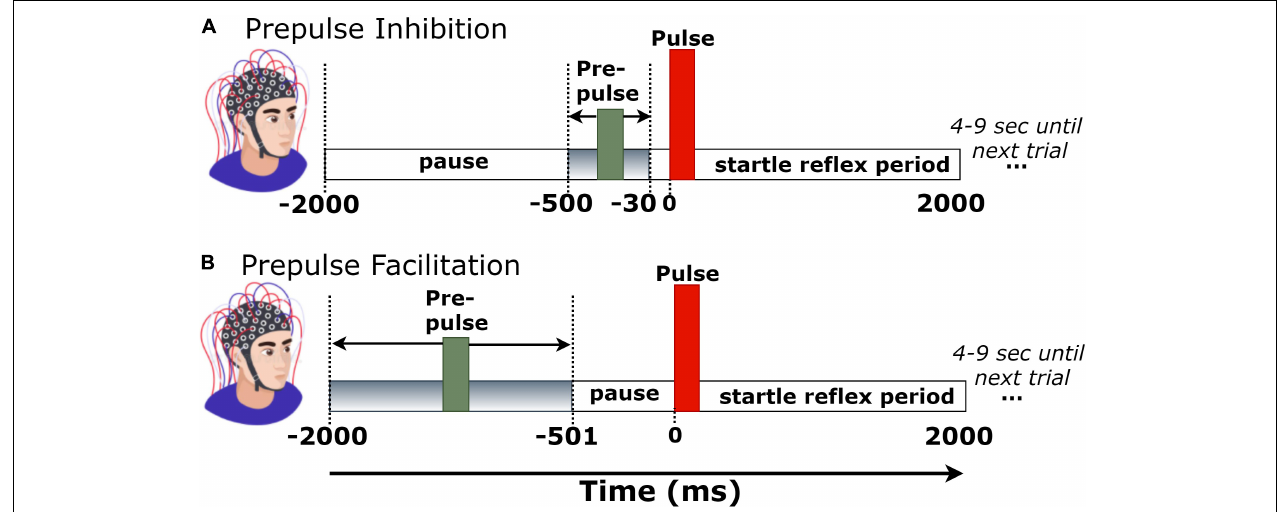
FIGURE 1 | Trial structure of (A) prepulse inhibition (PPI) and (B) prepulse facilitation (PPF)